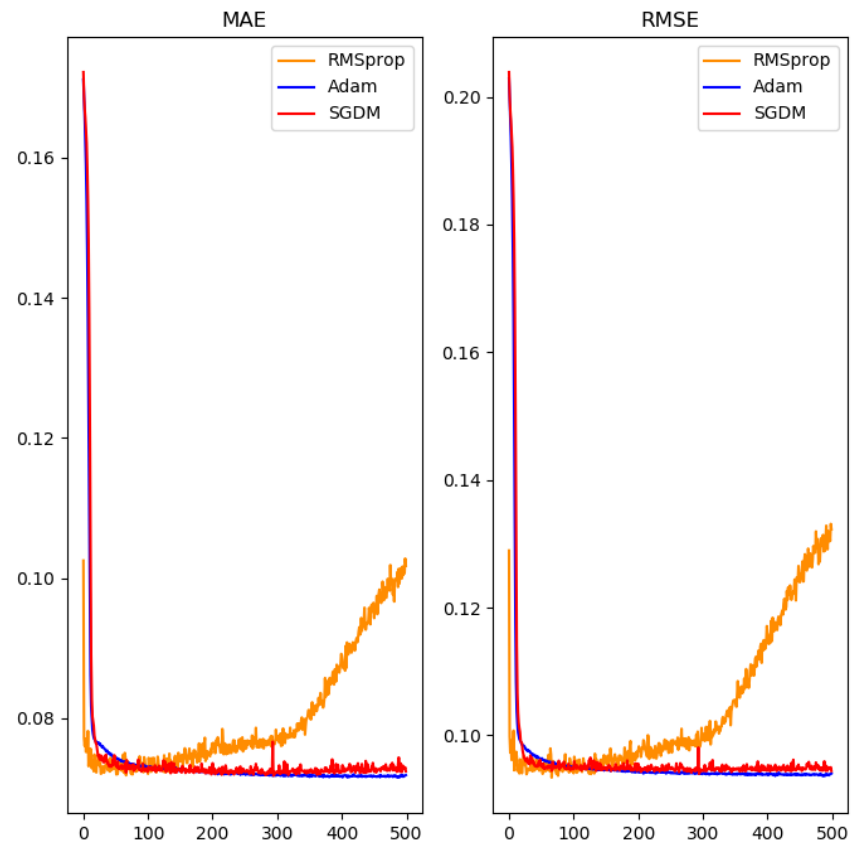
Figure 10. Neural network using different gradient descent methods for comparison.